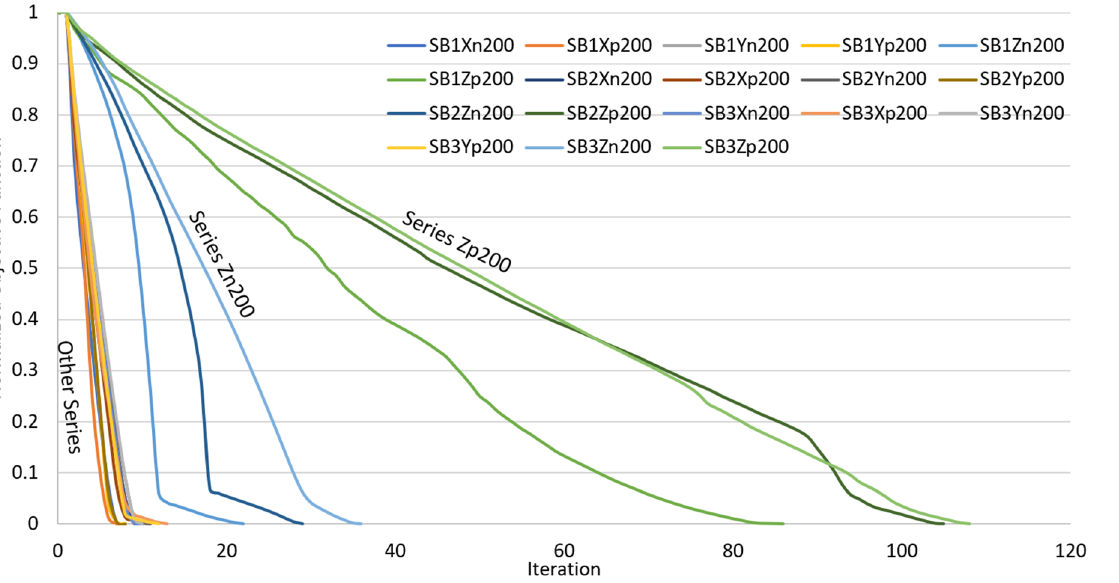
Figure 9. Convergence history for 18 shape change analysis cases in the uni-directional mode with target displacement of 200 mm.